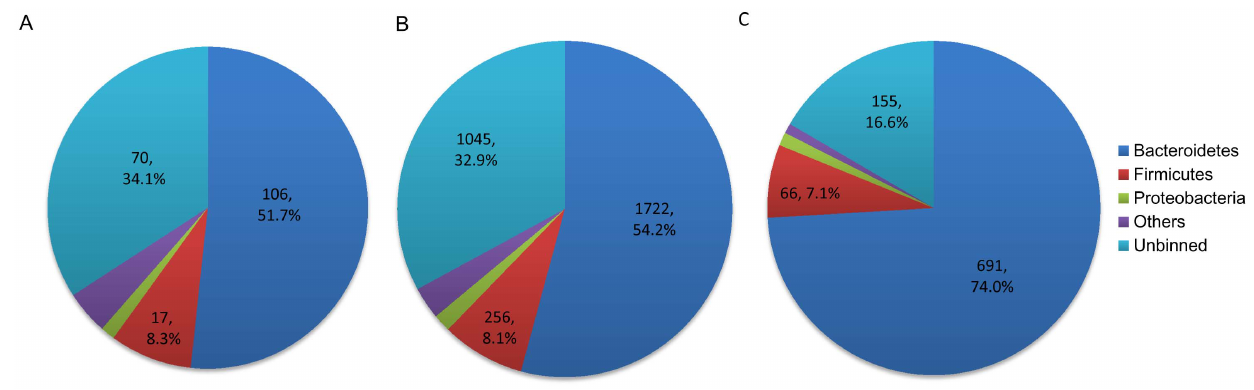
Figure 2. Taxonomic assignment of metagenomic fragments associated with plant and fungal cell wall degradation. Taxonomic assignment of CAZymes associated with degradation of main chains of plant cell wall polysaccharides (A), short or side chains thereof (B), and fungal cell wall saccharides (C). doi:10.1371/journal.pone.0069184.g002 PLOS ONE |